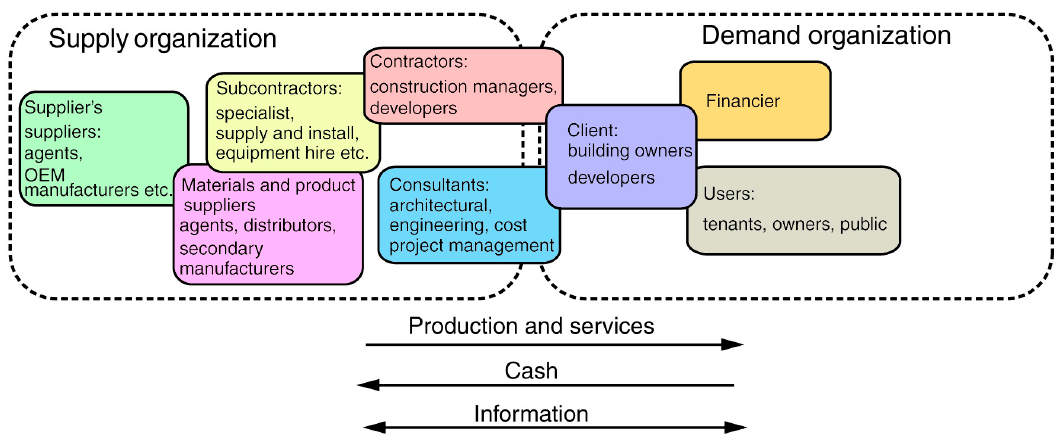
Figure 1. The framework of construction supply chains presented by London [8].